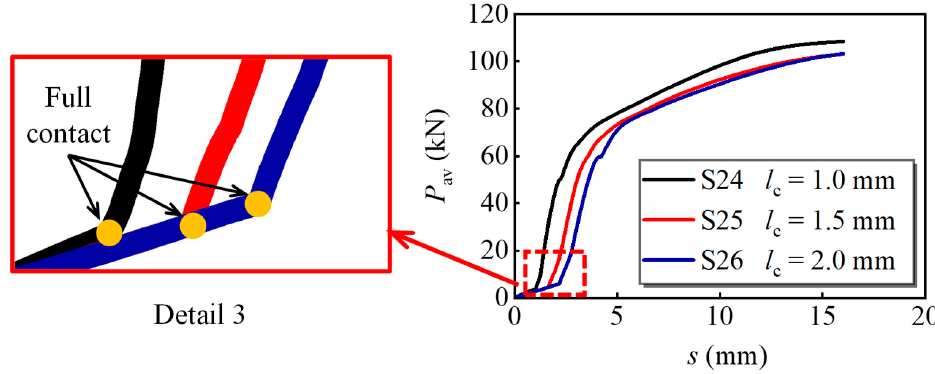
Figure 18. Variation of the load versus slip curves for models with different bolt-hole clearances.